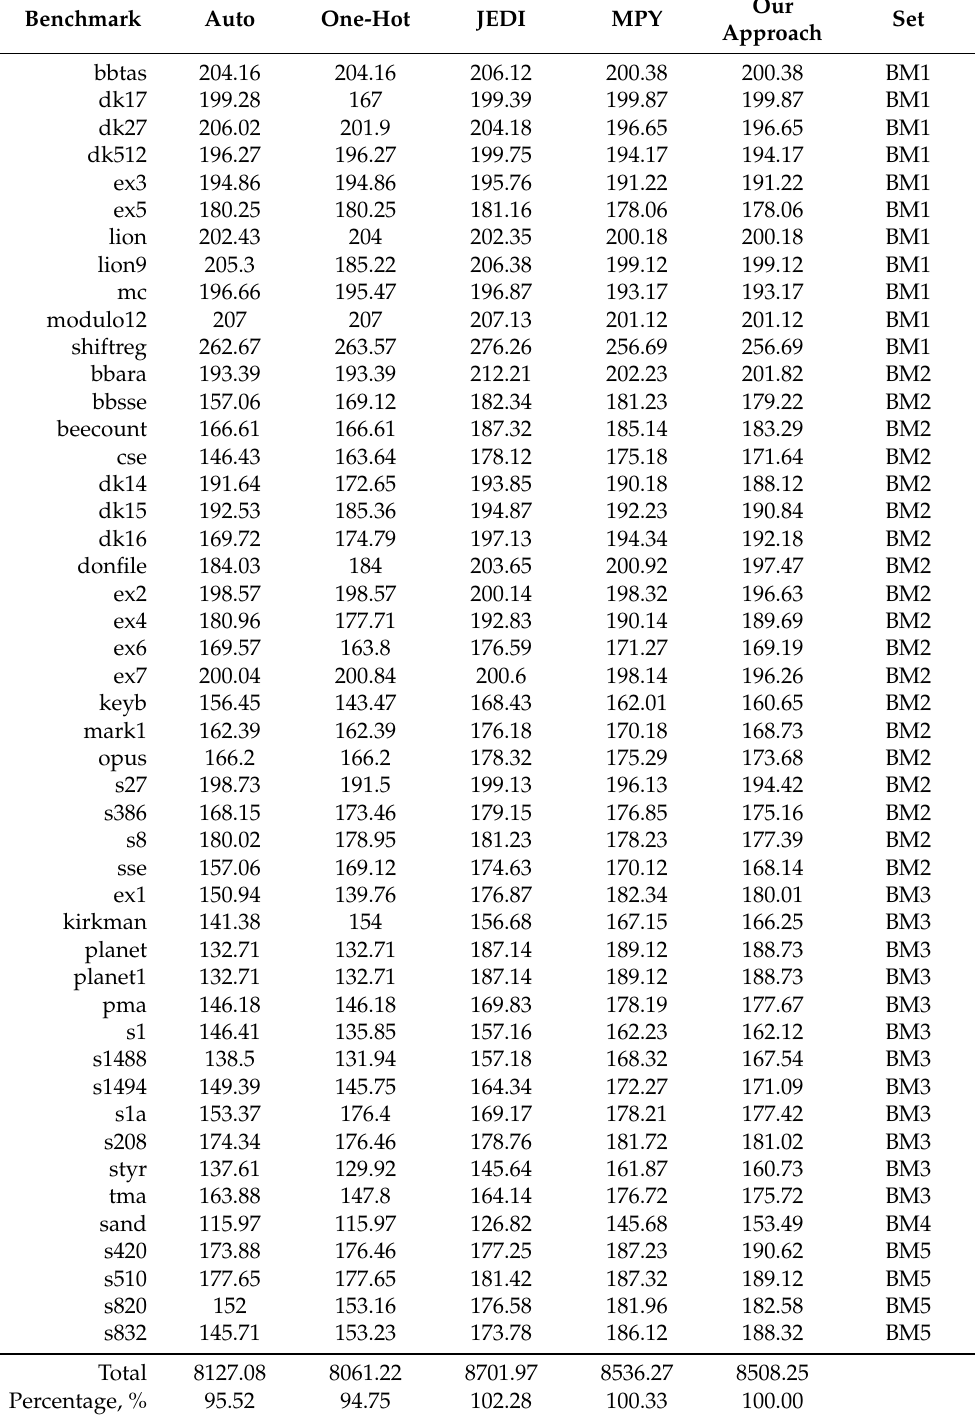
Table 13. Experimental results (the maximum operating frequency for BM1–BM5,